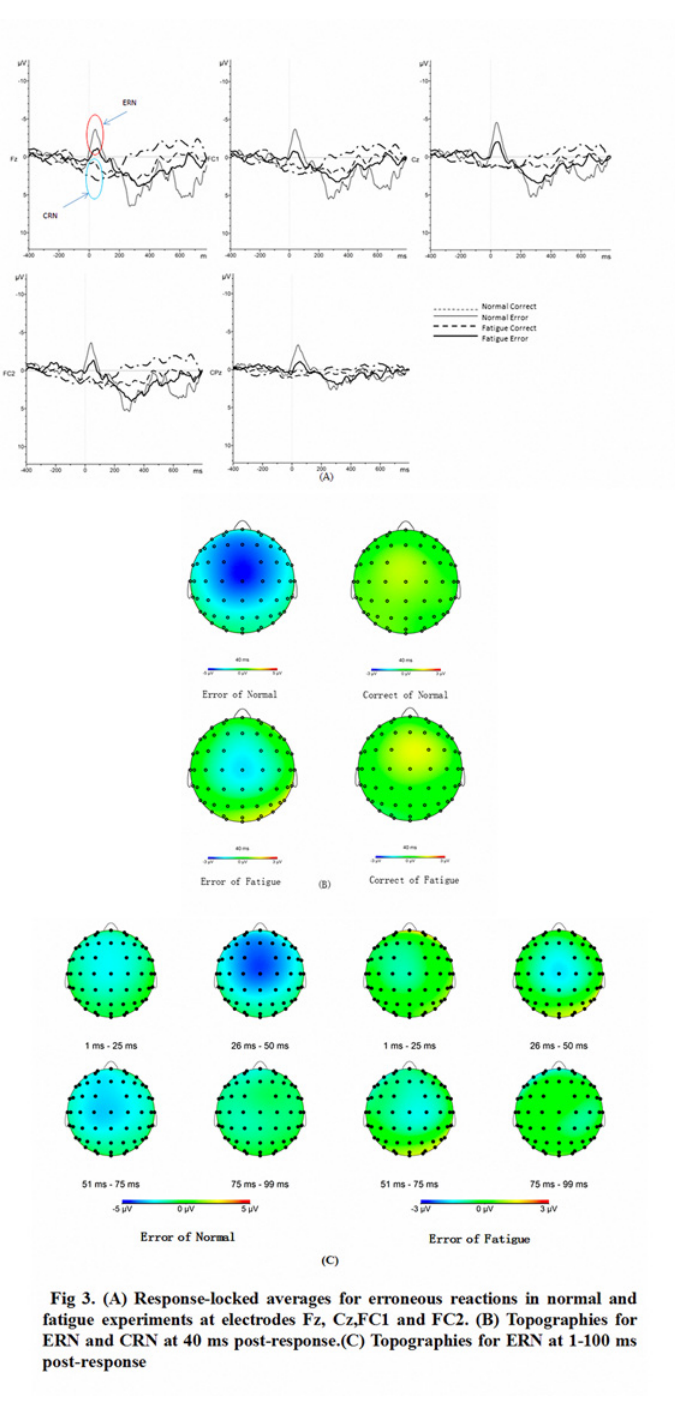
Fig 3. ERN/CRN at electrodes Fz, Cz, FC1, and FC2 in the two experiments. (A) Response-locked averages for erroneous reactions in normal and fatigue experiments at electrodes Fz, Cz,FC1 and FC2. (B) Topographies for ERN and CRN at 40 ms post-response.(C) Topographies for ERN at 1 – 100 ms post- response.